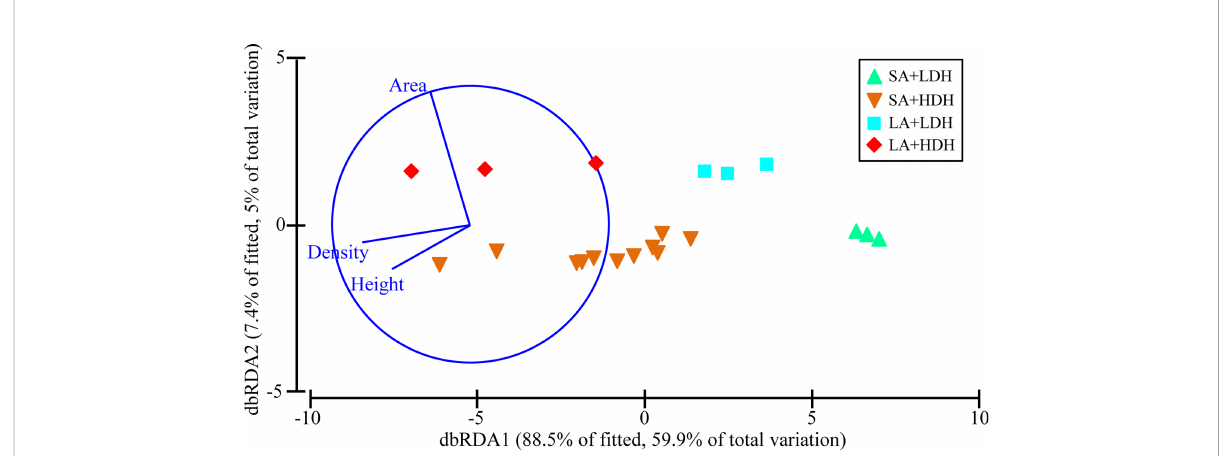
FIGURE 2 Distance-based redundancy analysis (db-RDA) ordination of putative bacterial pathogen data fi tted to seagrass canopy structure variables. The plot represents a db-RDA ordination based upon the Bray – Curtis distance of all the sampling